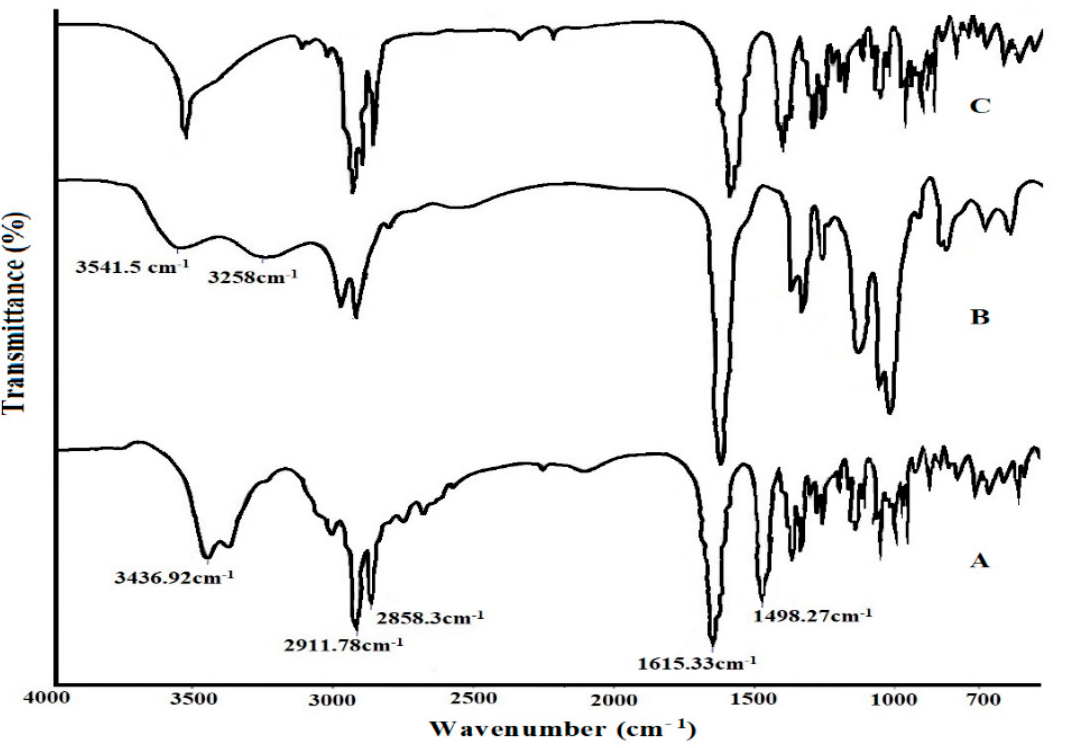
Figure 6. Overlay FTIR spectra of (A) pure Saxagliptin, (B) Eudragit RS100, and (C) optimized SLN formulation.